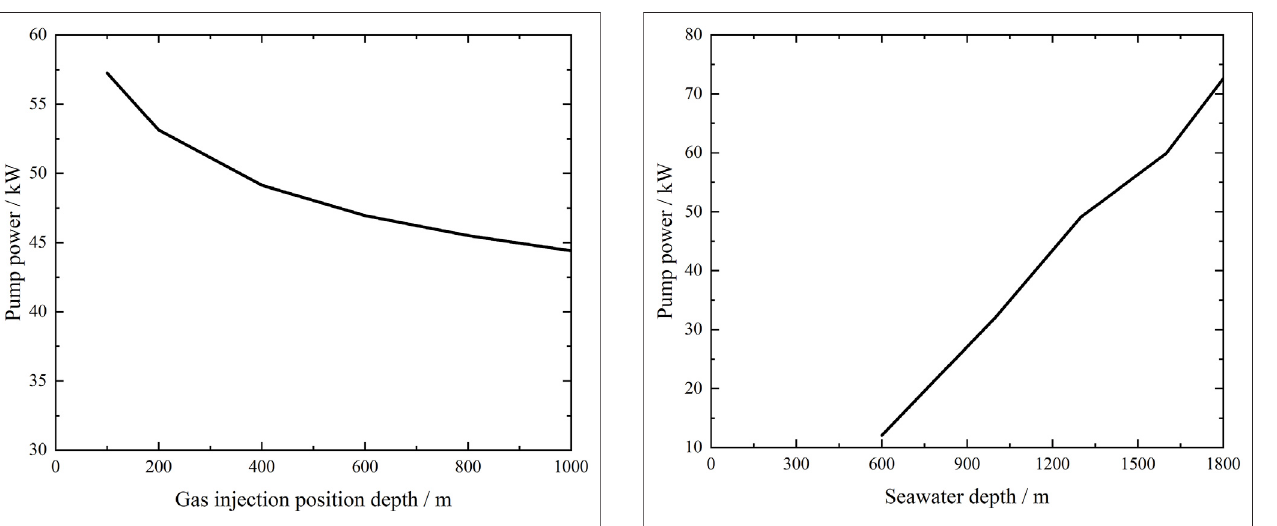
FIGURE 12 | Effect of gas injection depth on pump lifting power. FIGURE 13 | Effect of seawater depth on pump lifting